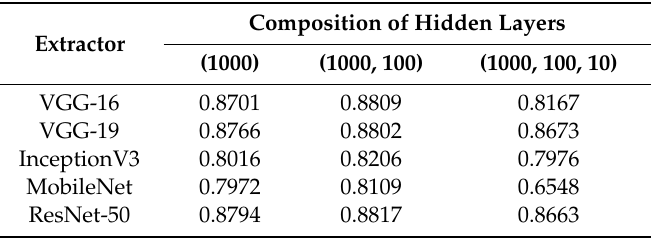
Table 8. Validation accuracy of di ff erent model structures.